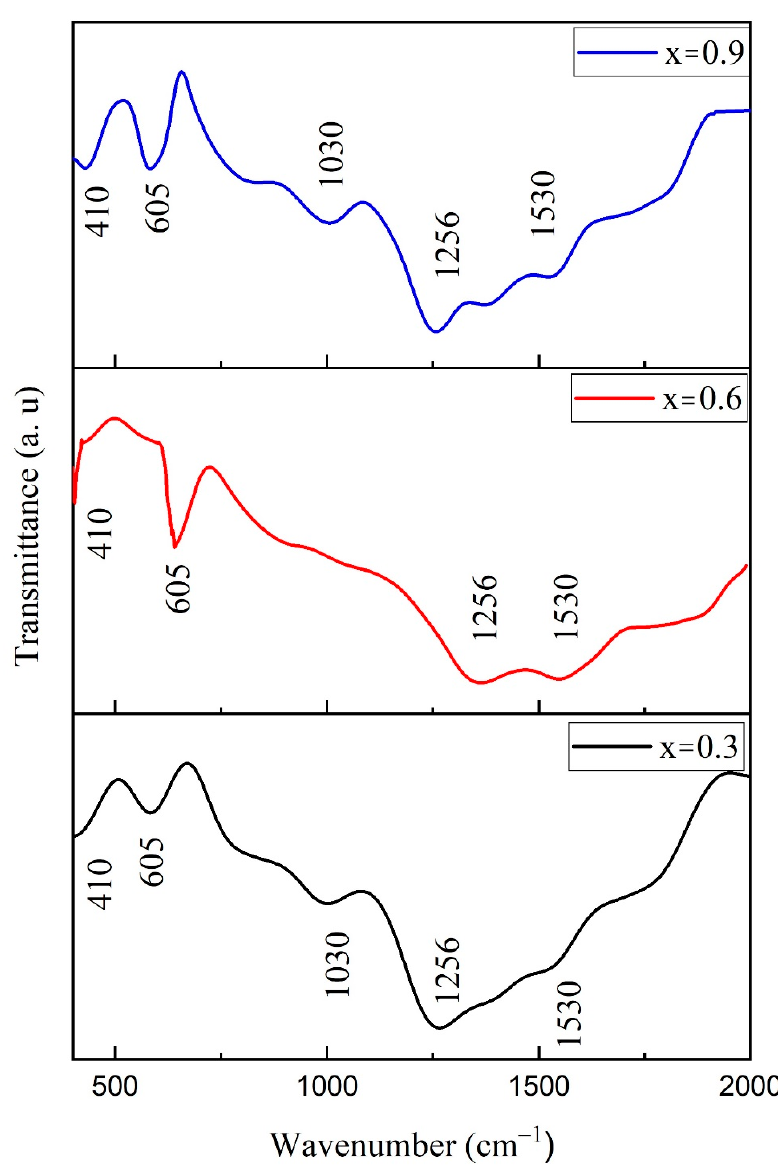
Figure 9. FTIR spectra of Cu ‐ doped cobalt ferrite (Co 1 − x Cu x Fe 2 O 4 ) nanoparticles with (x = 0.3, 0.6,